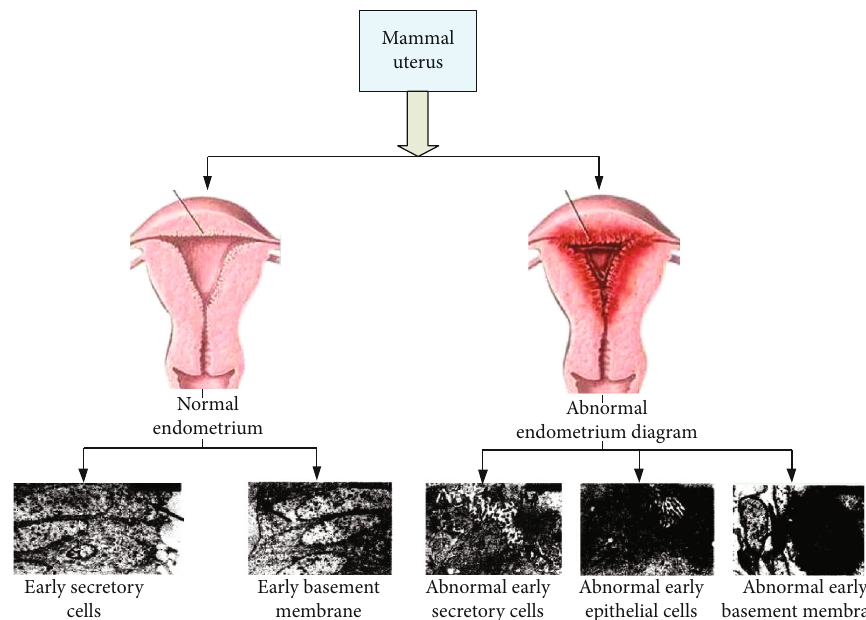
Figure 5: The development process of normal uterine wall and ectopic uterine wall.